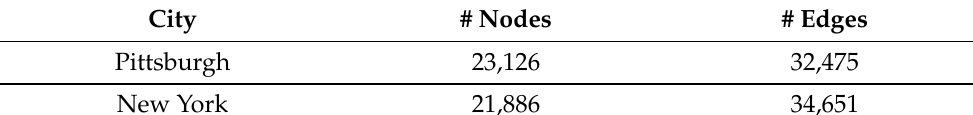
Table 2. Number of nodes and edges for road networks in Pittsburgh and New York City.